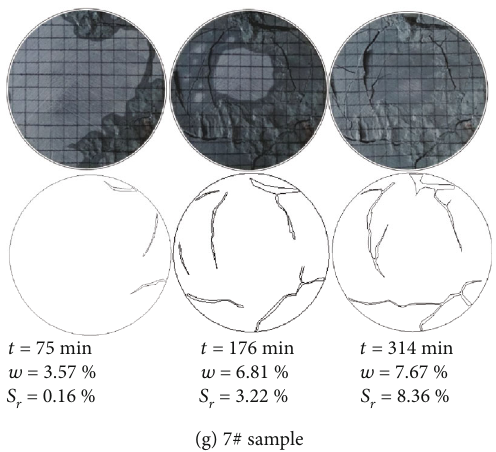
Figure 5: Cracking pictures of